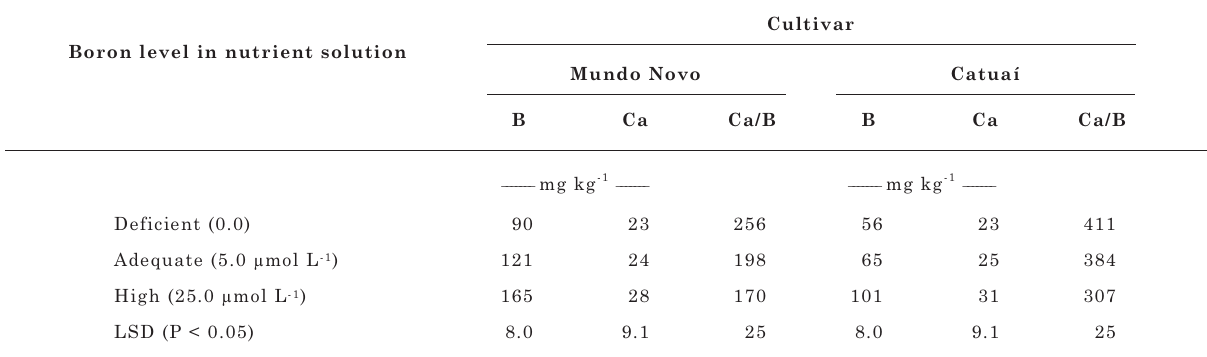
Table 2. Boron, Calcium and Ca/B ratio in leaf cell walls of coffee trees as affected by B deficiency and cultivar